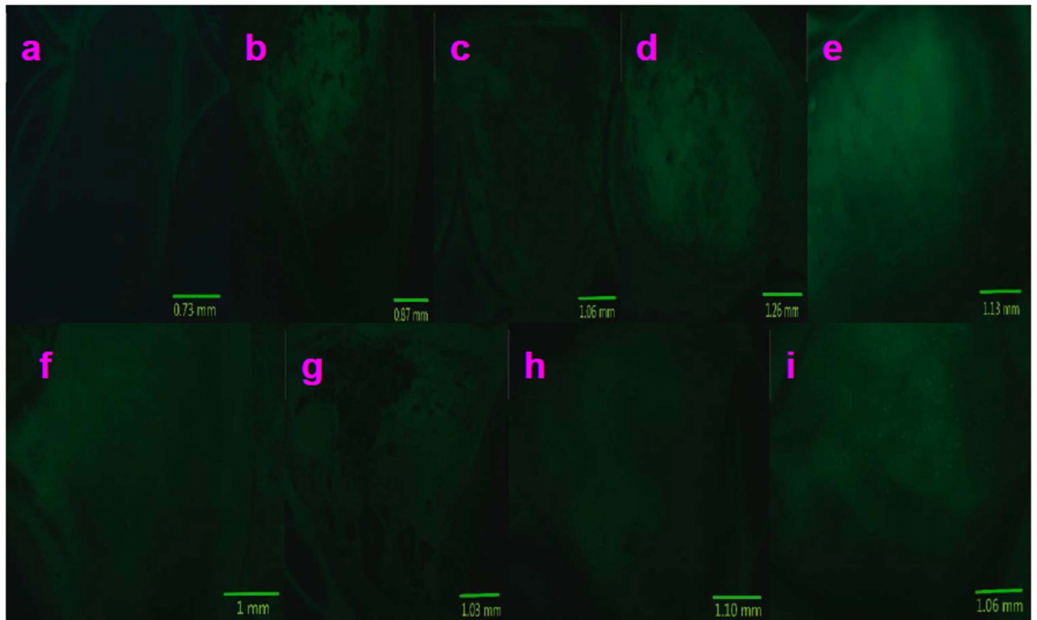
Figure 9. Fluorescence images of pig kidney coated with Sm–Me (Me = Fe, Ga, Mn, Na, Nb, W, Cu, and Al) nanoparticles are generated when blue-light excitation (450–490 nm) is used: ( a ) Control (no nanoparticles are used); ( b ) Sm–Fe; ( c )Sm–Ga; ( d ) Sm–Mn; ( e ) Sm–Na; ( f ) Sm–Nb; ( g ) Sm–W; ( h ) Sm–Cu; ( i )